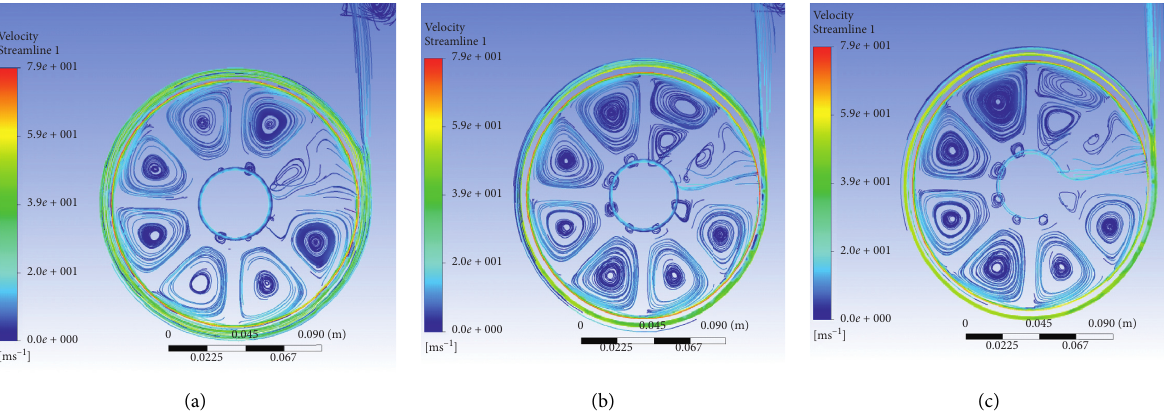
Figure 5: Streamline distribution without inducer at different flow rates. (a) Q